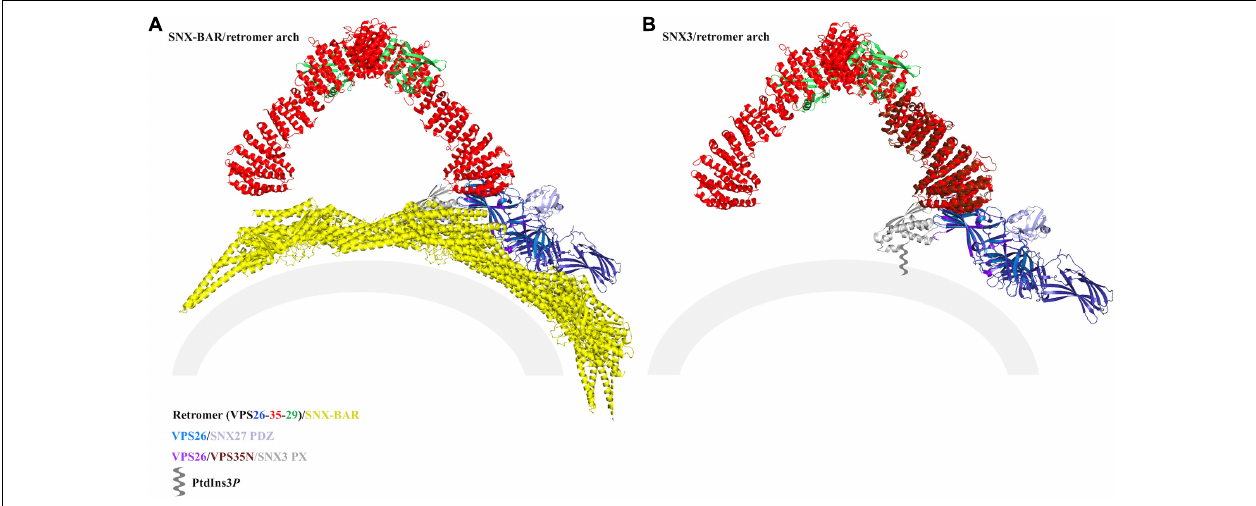
FIGURE 6 | Modeling SNX27/retromer on membranes. Thermophilic yeast SNX-BAR/retromer (PDB ID: 6H7W) (A) and mammalian SNX3/retromer coats (B) (PDB: not yet available) have been reconstituted in vitro . The view in panel (B) was generated using PDB: 5F0J, which approximates the reported SNX3/retromer architecture. Both complexes drive tubulation, and reconstructions indicate retromer forms conserved asymmetrical V-shaped arches across eukaryotes. VPS35 is shown as red ribbons, VPS26 as blue ribbons, VPS29 as green ribbons, Vps5 as yellow ribbons, and the SNX3 PX domain as gray ribbons. On each model, potential locations for SNX27 domains are marked. In the SNX-BAR/retromer model (A) , the SNX27 PX domain (gray ribbons) appears to be occluded by BAR dimers, and the PDZ domain would likely be blocked from engaging membrane cargo by the BAR layer. In the SNX3/retromer model (B) , the SNX27 PX (gray ribbons) and PDZ (purple ribbons) domains are both located close to the membrane. There are currently no structural data regarding the overall architecture of SNX27, either on its own or as part of a retromer coat, so the location of the FERM domain remains unknown. Both models assume the SNX27 PX occupies a similar location to SNX3